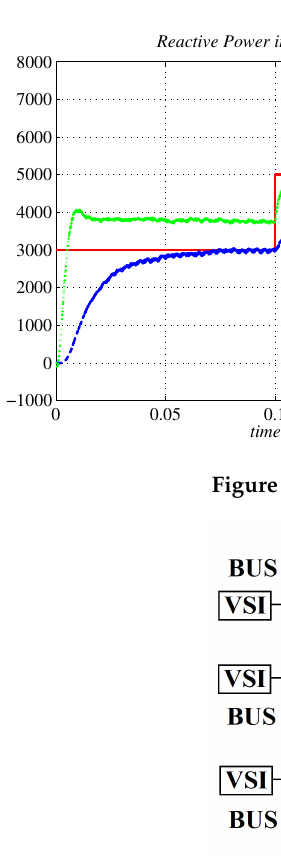
Figure 14. Microgrid of four buses with nonlinear loads.